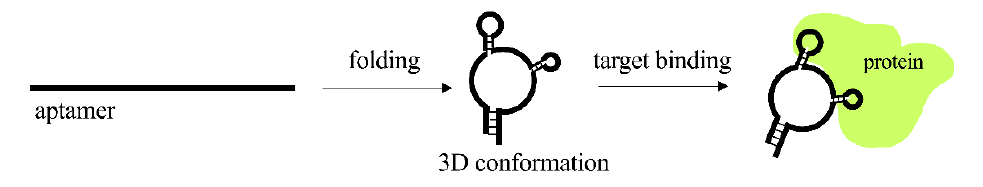
Figure 4. Mechanism of action of aptamers.